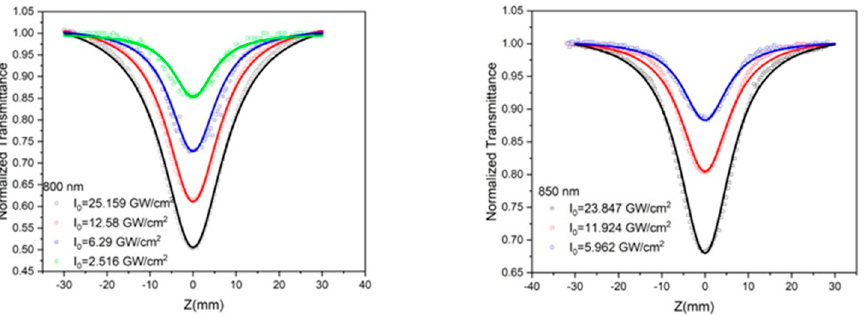
Figure 3. Femtosecond OA Z-scan experiments of ZL-61 at 800 nm and 850 nm. The dots represent experimental data and the lines represent theoretical fitted curves. Table 2. NLO Parameters of ZL-61 and ZL-22 determined by the femtosecond Z-scan experiments. β represents the two-photon absorption coefficient, and γ represents the effective three-photon absorption coefficient.